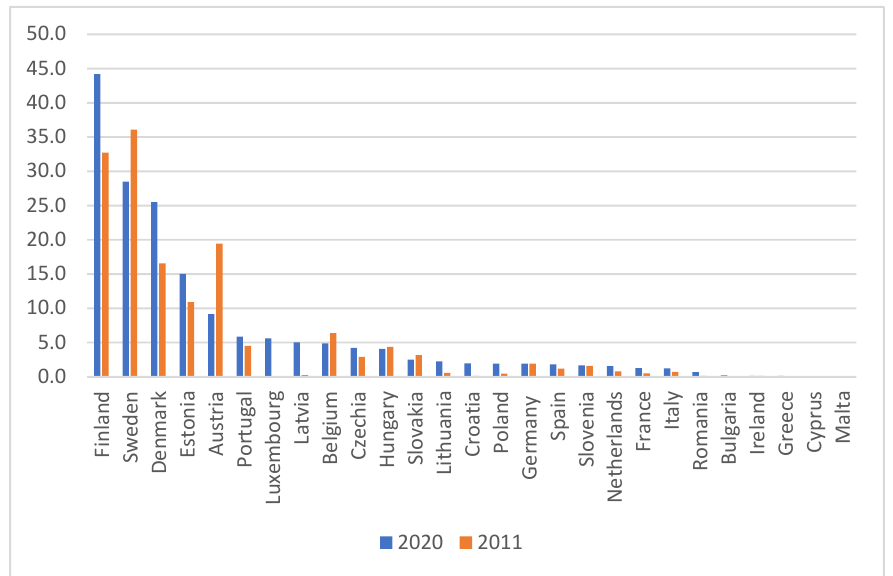
Figure 4. Energy production from renewable sources (solar energy in megawatts per 100,000 population).